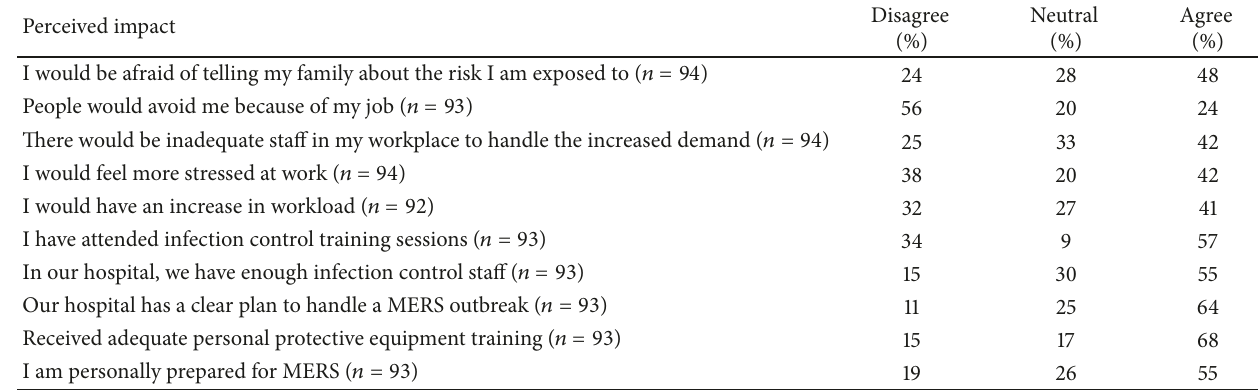
Table 3: Percentages of responses to perceived impact on personal life, workload, and preparedness for a Middle East respiratory syndrome coronavirus outbreak by emergency room resident physicians. Perceived